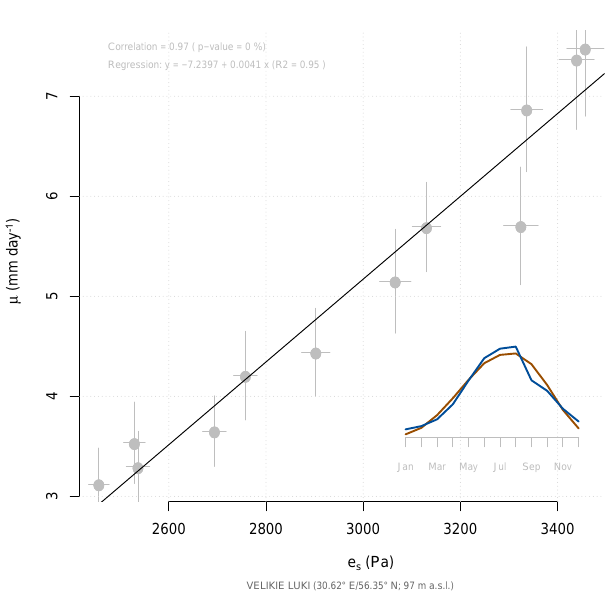
Figure 1. A comparison between the mean seasonal cycle in the saturation vapour pressure ( x axis) and the wet-day mean ( y axis) for the site Velikie Luki, Russia. The error bars indicate 2 standard deviations of the year-to-year variations in the two variables. An inset shows the standardised seasonal cycles, both variables peaking in July–August (red line = e s , blue line = µ